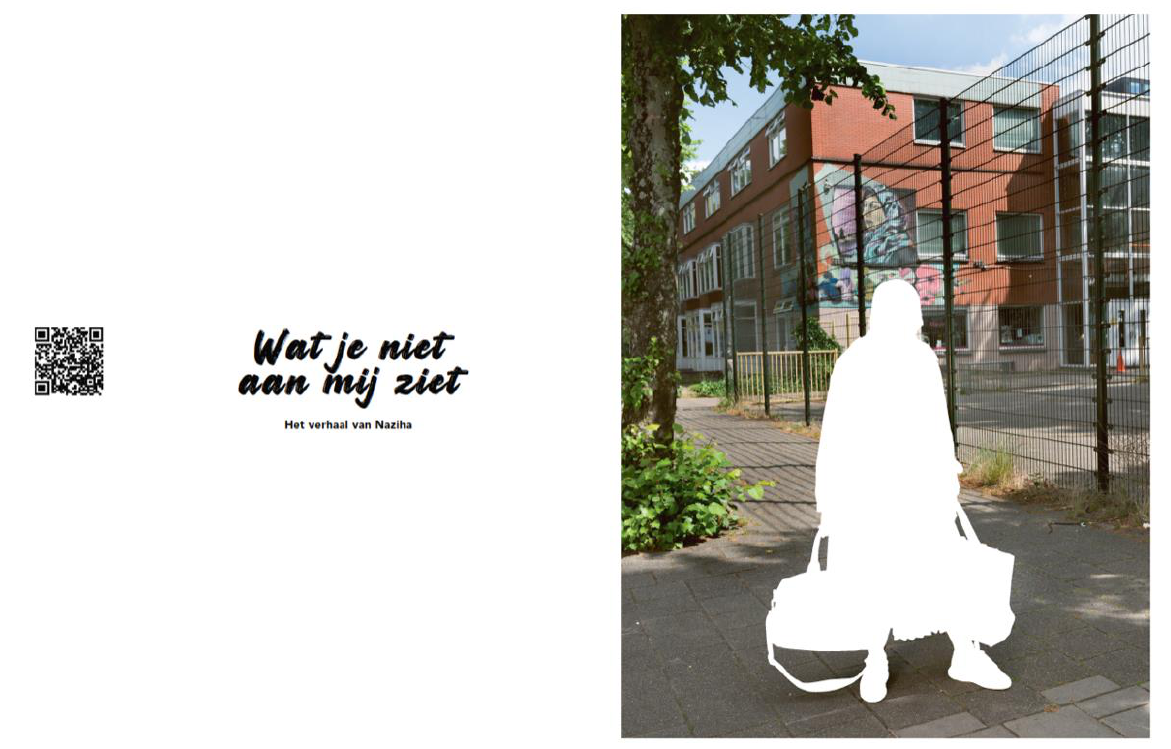
Figure 9. Images in book “What You Don’t See” .